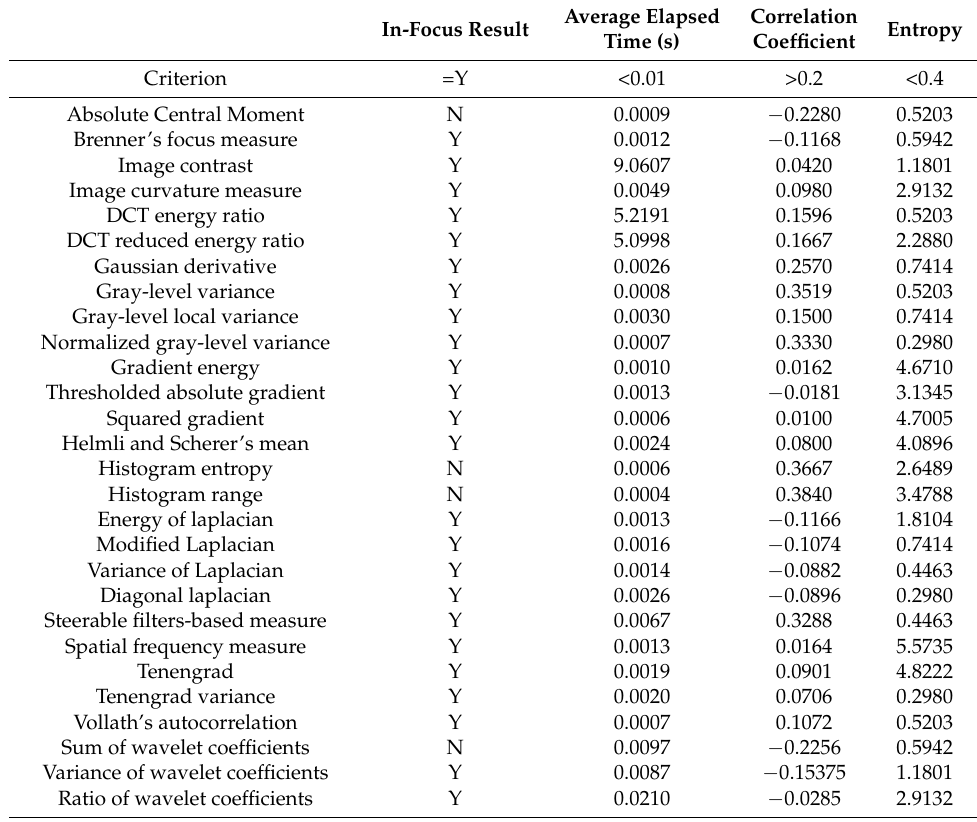
Table 1. Statistical sharpness estimation comparison.